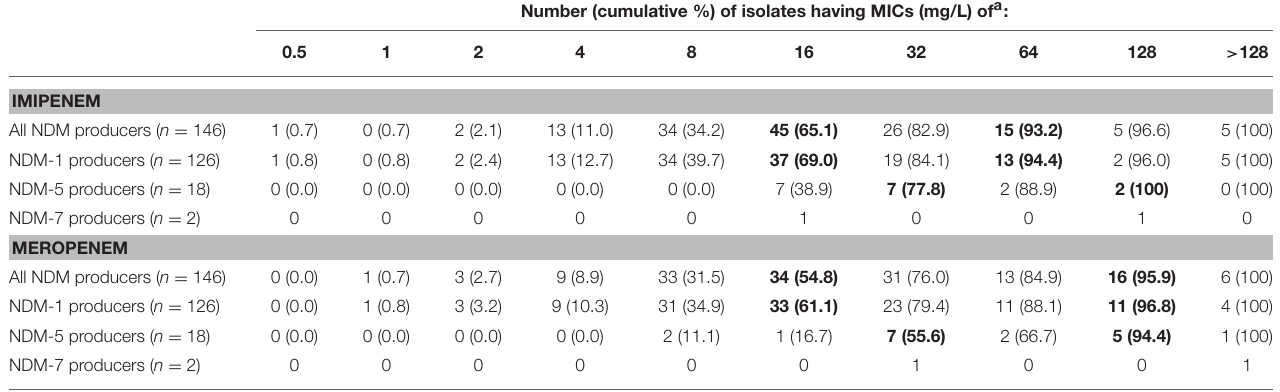
TABLE 1 | Distribution of carbapenem MICs in NDM producers by subtype. Number (cumulative %) of isolates having MICs (mg/L) of a :